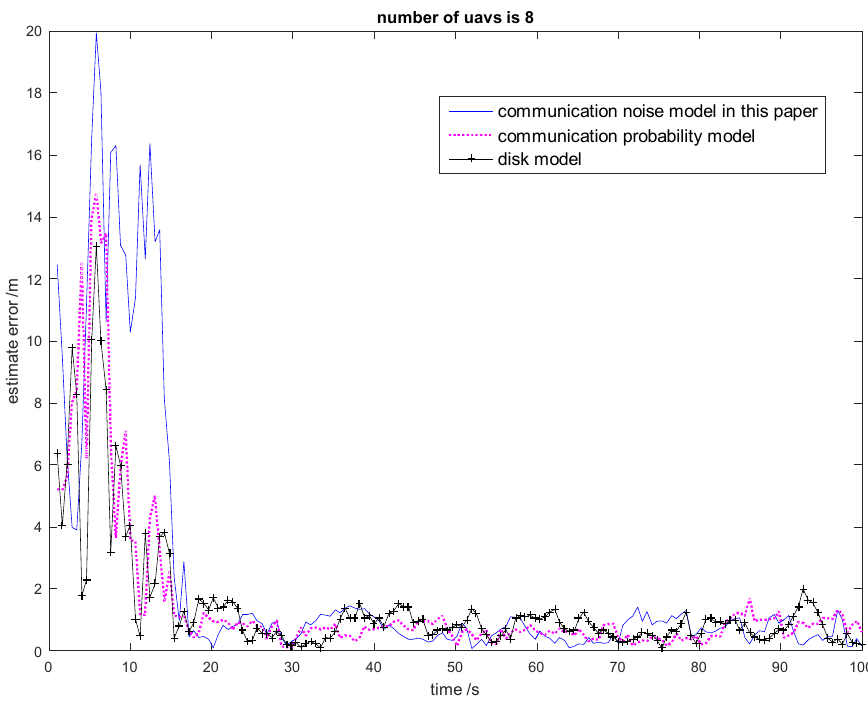
Figure 11. Estimate error with different methods (number of UAVs was 8).